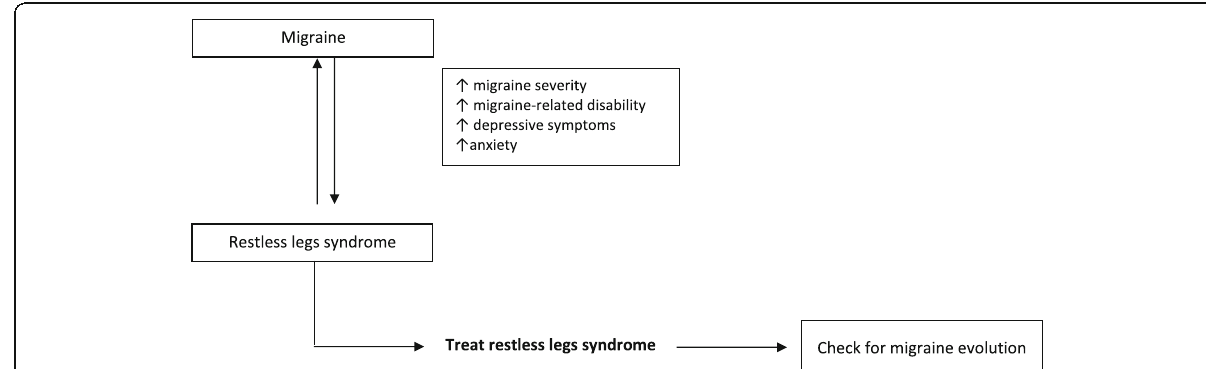
Fig. 4 Interaction between migraine and restless legs syndrome. Available evidence suggests the existence of a bidirectional association between migraine and restless leg syndrome (RLS). RLS in patients with migraine seems to be associated with higher migraine frequency and related disability. It would be reasonable to systematically check patients with migraine for symptoms of RLS and adopt specific RLS treatments if needed; this approach should be considered complementary to that of migraine and may lead an improvement of migraine frequency and related disability. In the decision-making process for the choice of migraine preventive treatment clinicians should consider the possible exacerbating effect of antidepressants on RLS symptoms, and their effectiveness should be balance over the possible worsening effect on